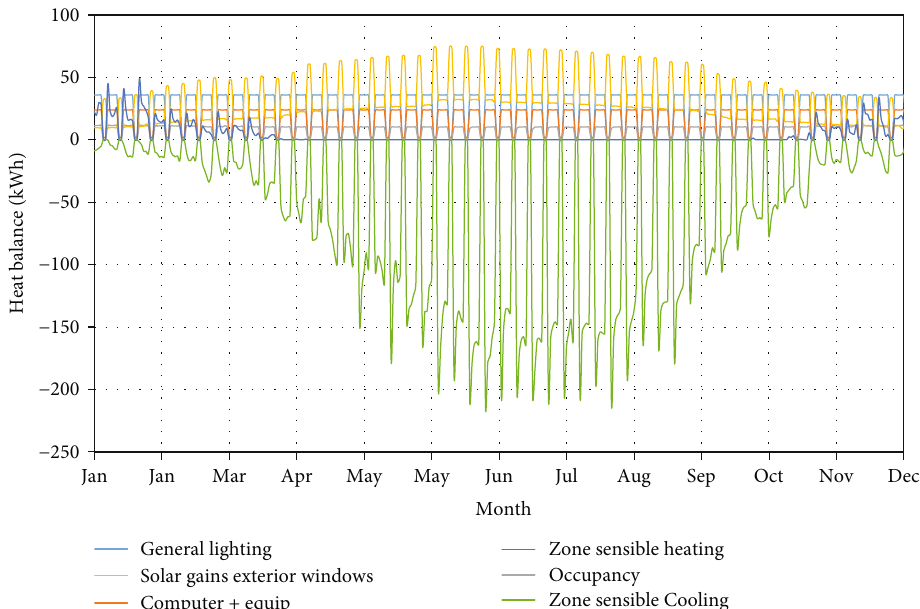
Figure 11: Daily consumed energy of the building within a year.